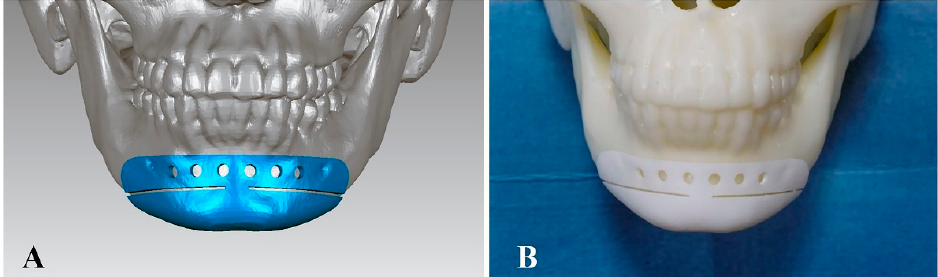
Figure 3. Surgical guide-assisted osteotomy. ( A ) Design of the surgical guide. ( B ) The 3D-printed surgical guide was placed on the skull model.